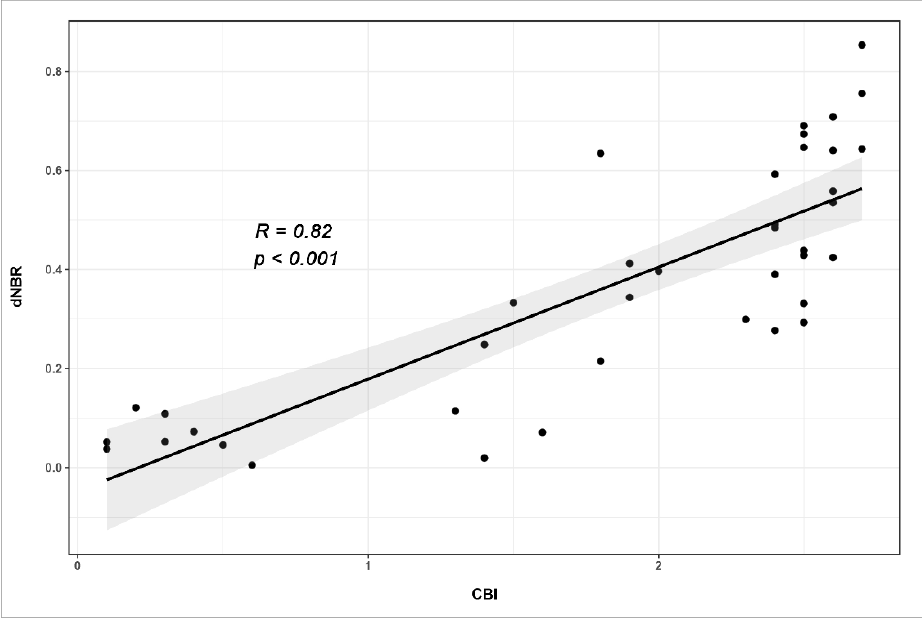
Figure 9. Correlation between CBI values and dNBR with Pearson correlation coefficients for 2019.